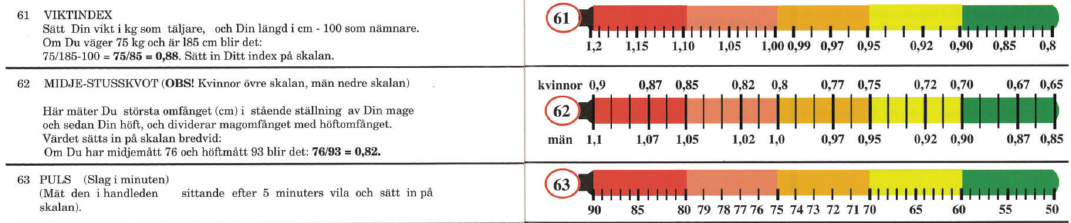
Figure 4: Numerical scales of self-assessed weight index, waist-to-hip ratio, and pulse in their actual population sample quintile distributions. In, for example, on-line internet/cloud implementations these can be automatically calibrated and age- and sex-standardized for the user pari passu with the global accumulation of